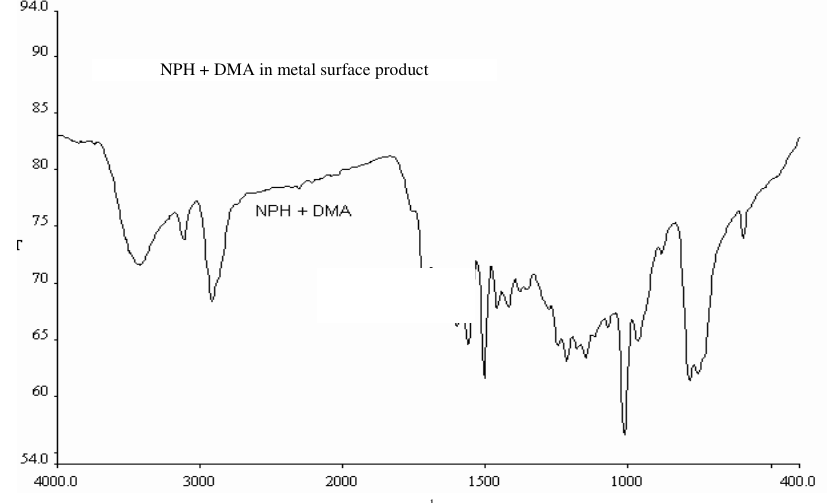
Figure 6. FTIR spectra of metal surface after immersion in the acid solution containing the binary mixture of NPH and DMA Table 7. Spectral study of FTIR for surface product of binary mixture NPH and DMA Pure